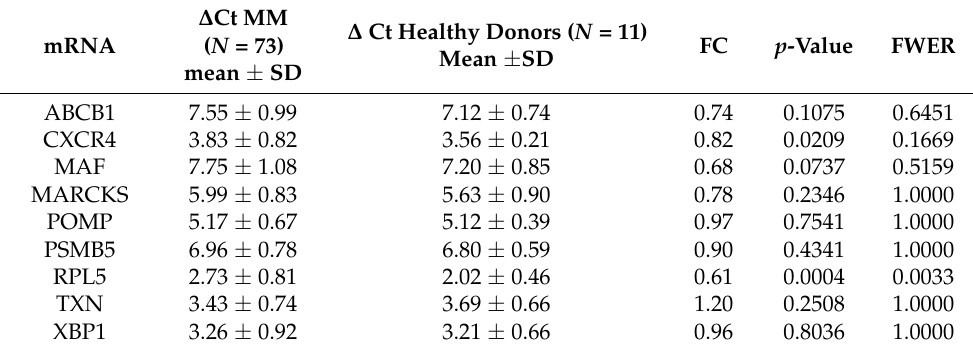
Figure 1. Flowchart of study protocol and main analyses. Abbreviations: CR—complete response; MM—multiple myeloma; OS—overall survival; PFS—progression-free survival. Table 2. mRNA expression in multiple myeloma patients and healthy donors. The higher ∆ Ct value represents the lower expression of gene at mRNA